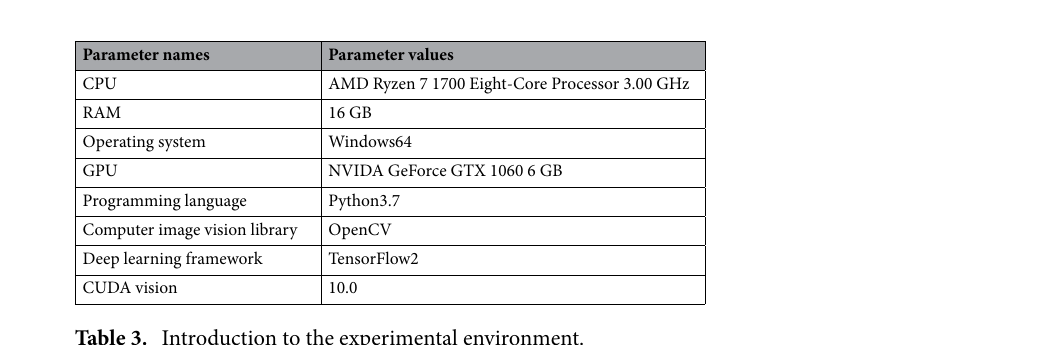
Table 3. Introduction to the experimental environment.